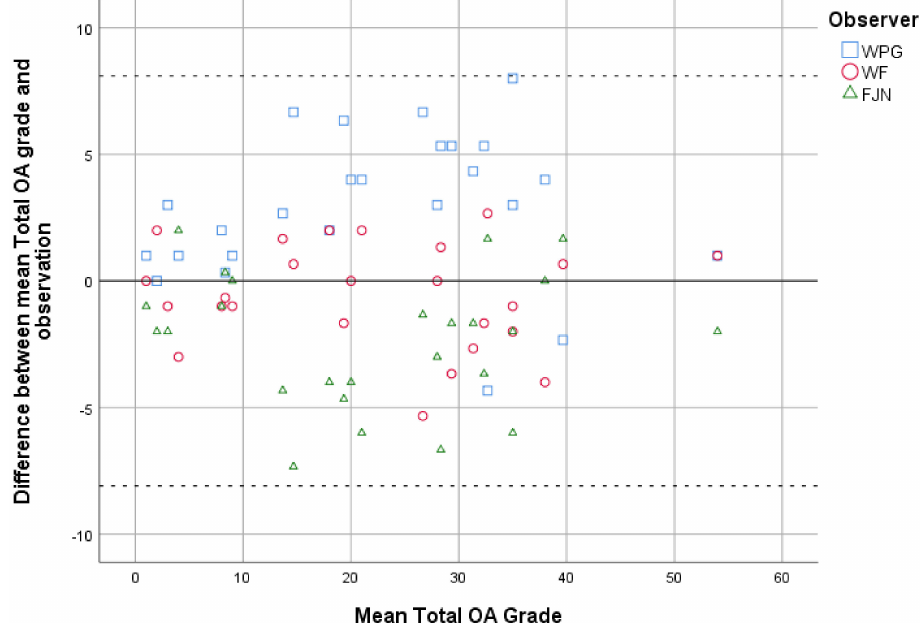
Figure 3. Jones plot depicting the difference between each observation of the different readers and the mean observed score for the total OA grade. The interrupted lines show the 95% limits of agreement.